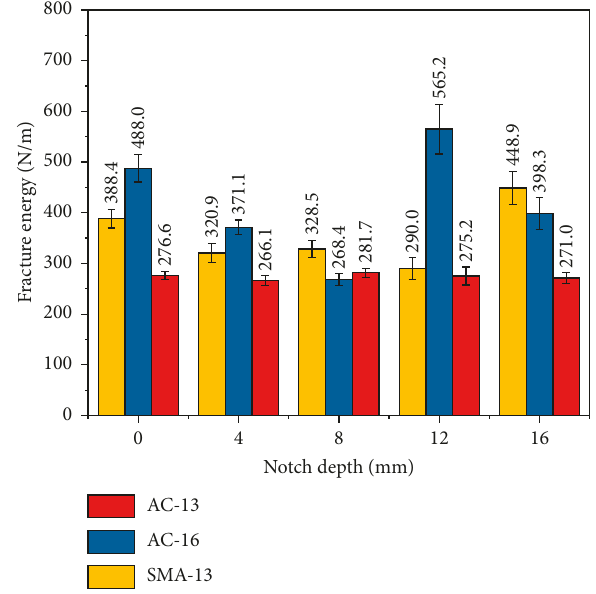
Figure 8: Fracture energy for different notch depths.